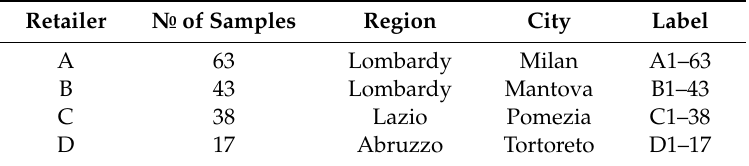
Table 1. The summary of the dataset used in this work. The 161 hemp samples were classified as sold by the four Italian retailers. Region and city origin of retailers were also